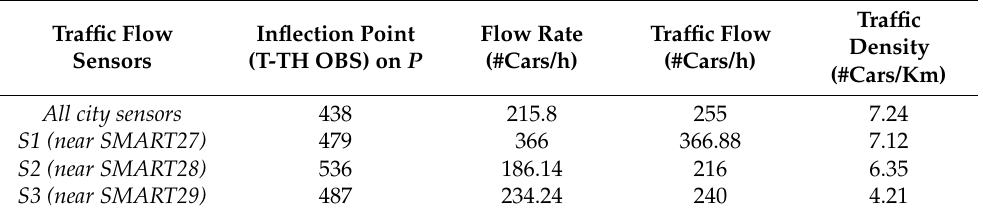
Table 3. An example of the coefficients related to the polynomial approximations of the MFR(Spring) and FR(Spring,i) for 3 traffic flow sensors during the (same) selected period of time in